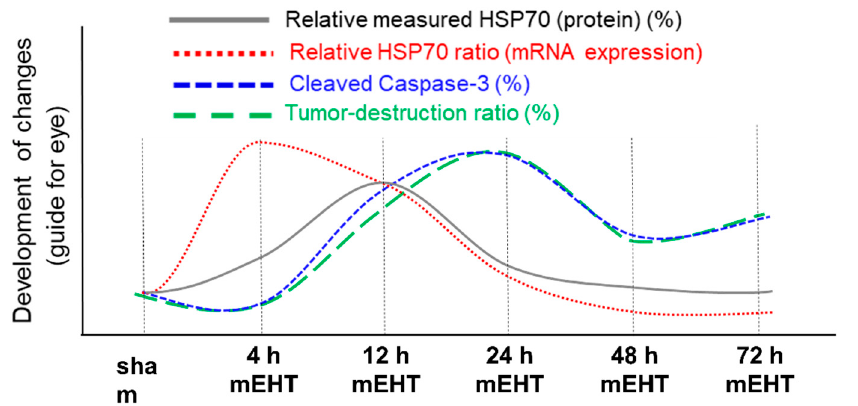
Figure 11. The trend of the development of tumor destruction, HSP expression, and cleaved caspase-3 at discrete time-points in 4T1 murine tumor isograft. The x-axis contains discrete steps, the curves are only to guide the eye.